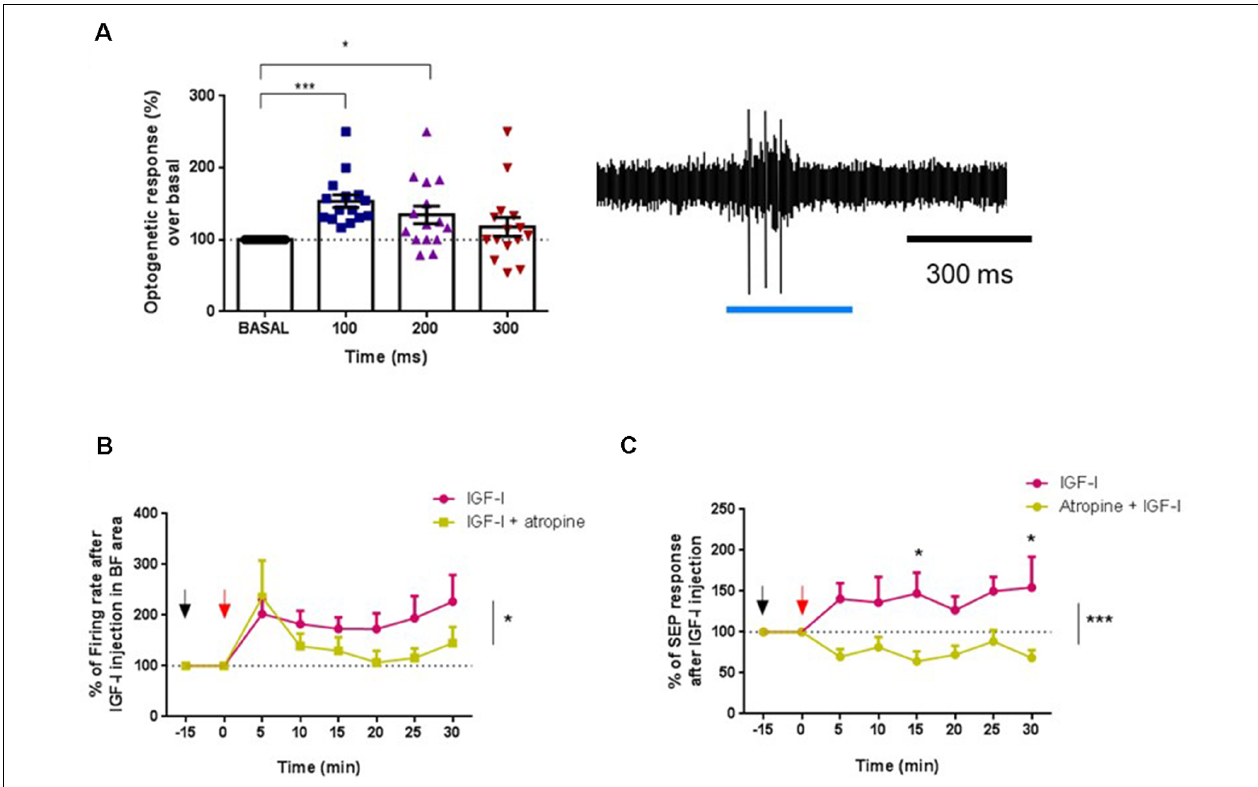
FIGURE 7 | The muscarinic antagonist atropine inhibited IGF-I effects in young animals. (A) Optogenetic identification of ChAT+ cells in young (ChAT-ChR2-YFP animals ≤ 6) before IGF-I administration. Blue-light pulses increased the firing rate activity between 0–100 ms (*** p < 0.0001) and 100–200 ms (* p < 0.0345, n = 16 neurons per group, F (2,386,33,40) = 8,191, One-way Repeated Measure ANOVA; Dunn’s multiple comparison test). Right inset a representative response of a typical ChAT+ cell to a blue-light pulse. (B) Fifteen minutes before IGF-I local injection (10 nM; 0.2 µ l, red arrow), atropine (1 mg/Kg in 0.9% NaCl, ip, black arrow) or saline (0.9% NaCl) were injected. The firing rate of ChAT+ cells is expressed as a percentage of basal activity at time 0 (IGF-I injection). Young mice administered with saline/IGF-I were compared with young mice injected with atropine/IGF-I. The long-lasting activation evoked by IGF-I was blocked by atropine (saline/IGF-I = 7 neurons, atropine/IGF-I = 9 neurons, F (1,151) = 4,878, * p = 0.0287; Two-Way ANOVA). (C) SEP facilitation by IGF-I was blocked by atropine i.p. injection. Saline/IGF-I ( n = 13 neurons) have higher SEP (%) compared with atropine/IGF-I over time ( n = 9 neurons; F (1,160) = 26,38, *** p < 0.0001; Ordinary Two-Way ANOVA), and especially at 15 min (* p = 0.0297 and 30 min * p = 0.216, Sidak’s multiple comparison